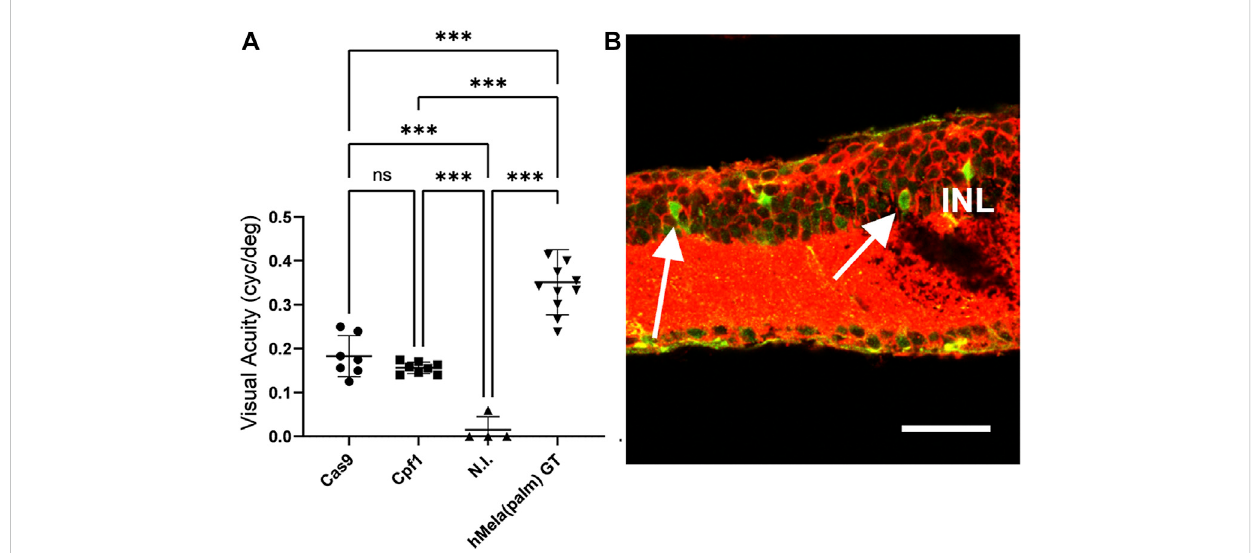
FIGURE 4 HITI-andMITI-mediatedandON-bipolarcell-targetedOpto-mGluR6knock-inrestoresvisualacuityinblindrd1mice. (A) Visualacuityof7-month- old rd1 mice treated with Exo-AAV1s carrying vectors for promoting Cas9-mediated HITI (HITI, n = 7) or Cpf1-mediated MITI (Cpf1, n = 8). Non-injected (N.I.) littermates ( n = 4) and a conventional AAV Opto-mGluR6 gene therapy (Opto-mGluR6 GT, n = 11) served as negative and positive control, respectively. Data are depicted as boxplots indicating the mean ± standard deviation. (B) Representative image of a rd1 retina transduced with the MITI Exo-AAV1 system and labeled against eGFP (transgene) and G α o (ON-BPC marker). Double-labeled ON-BPCs (arrows) con fi rm successful MITI- mediated KI. INL, inner nuclear layer. Scale bar = 50 μ